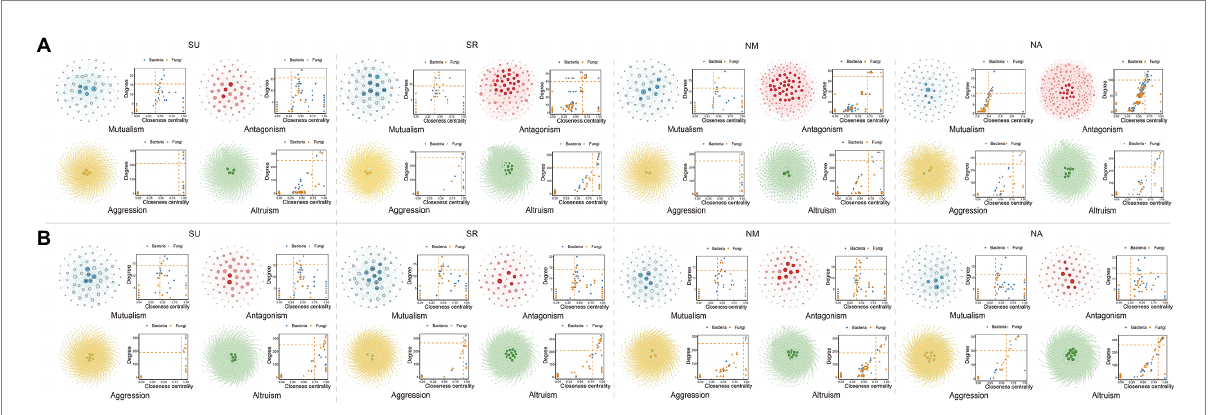
FIGURE 2 Ecologically hub OTUs of the co-occurrence network. (A) The results of four experiments in 2012, (B) The results of four experiments in 2013. In each network, hub microbes are highlighted in border colors. The distribution of ‘Hub microbes’ in four different microbial networks was based on degree and closeness centrality values. These two values of each OTU within each network were given at the right. The red dotted line represents the screening cutoffs of ‘Hub microbes’ corresponding to each network. Visualization was done with Gephi for four microbial